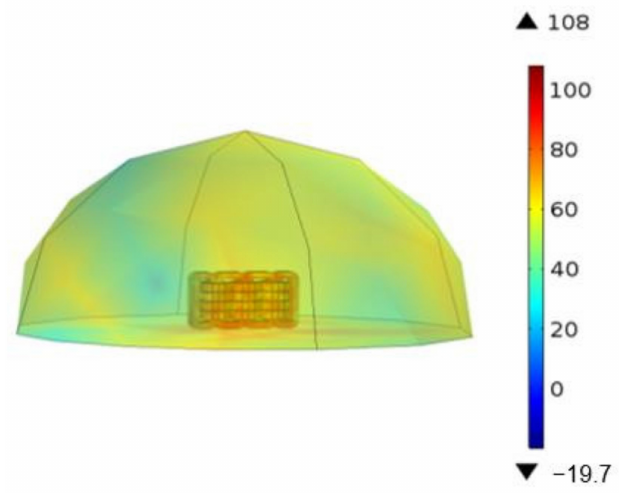
Figure 8. Distribution of SPL around transformer (dB).